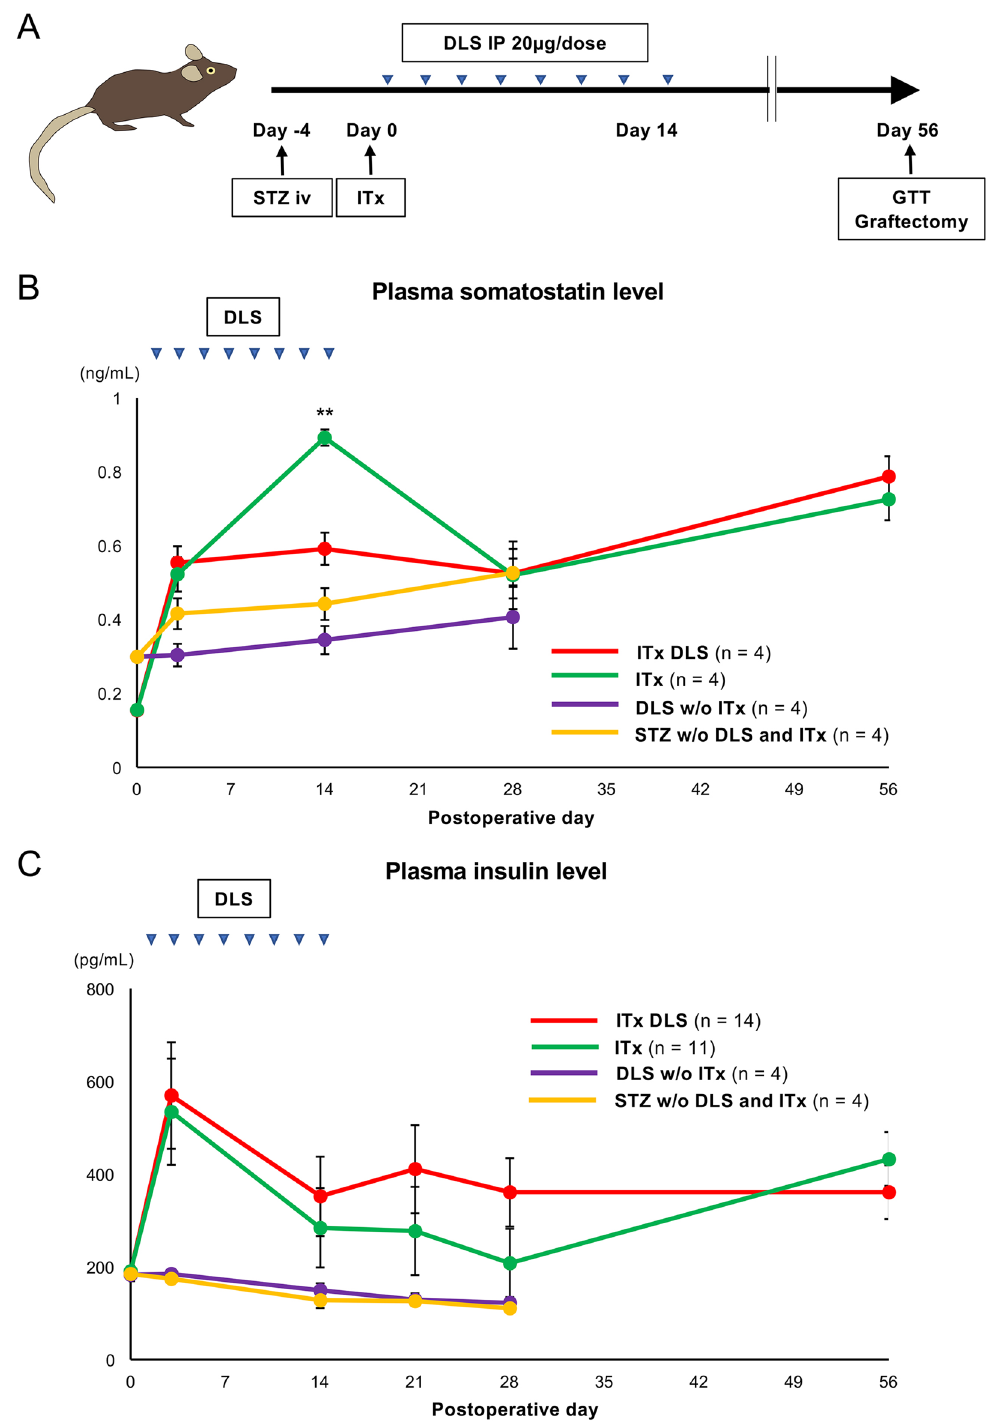
Figure 4. Therapeutic effect of the GHS-R1a antagonist in islet transplantation. ( A ) Scheme of DLS treatment protocol for islet transplantation (ITx DLS group). ( B ) Changes in plasma somatostatin level in the ITx DLS, ITx, DLS w/o ITx and STZ w/o DLS, and ITx groups. ( C ) Changes in plasma insulin level in the four groups. Triangles indicate the day of DLS injection. Data are presented as means ± SEMs. P value of < 0.05 was considered statistically significant. ( D ) and ( F ) Blood glucose ( D ) and body weight ( F ) levels after islet transplantation in ITx DLS ( red ; n = 14), ITx ( green ; n = 11), DLS w/o ITx ( n = 5), and STZ w/o DLS and ITx (n = 4) groups. ( E ) Blood glucose levels before and after graftectomy in the ITx DLS group. ( G) Glucose tolerance test (GTT) at POD 56. The data shows the area under the curve for the blood glucose level (AUC-GTT). Data are presented as means ± SEMs. P value < 0.05 was considered statistically